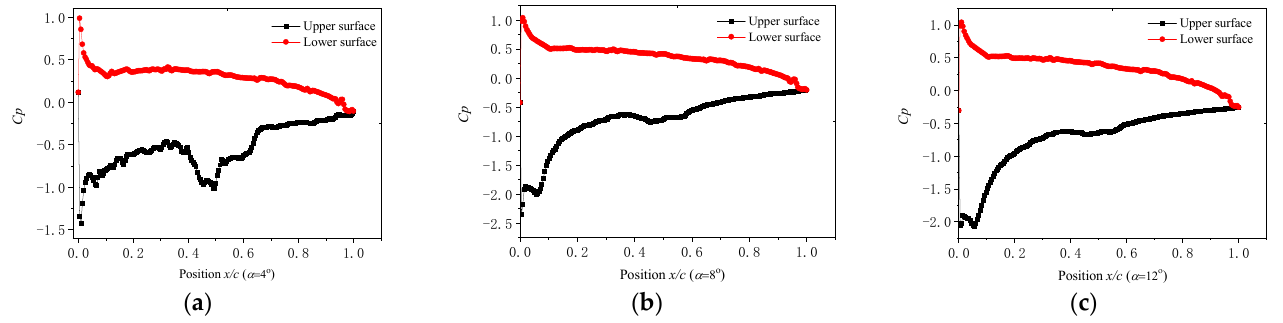
Figure 6. Pressure coefficient distribution line of presented airfoil surface at Re 70,000. ( a ) α = 4°; ( b ) α = 8°; ( c ) α = 12°. Figure 7 shows the thrust distribution at 1970 r/min, 2090 r/min, 2210 r/min and 2330 r/min. It can be seen that the thrust increased linearly as the position was less than 0.6 R and reached a maximum at 0.75 R.